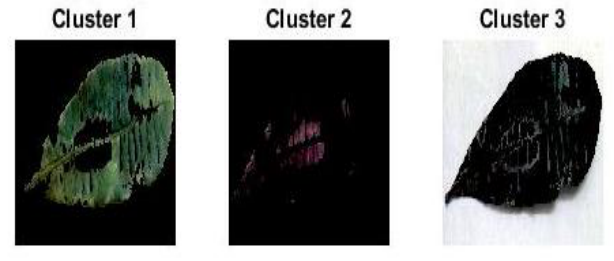
Figure 12. Cluster size 3 and 180 °co-occurrence angle